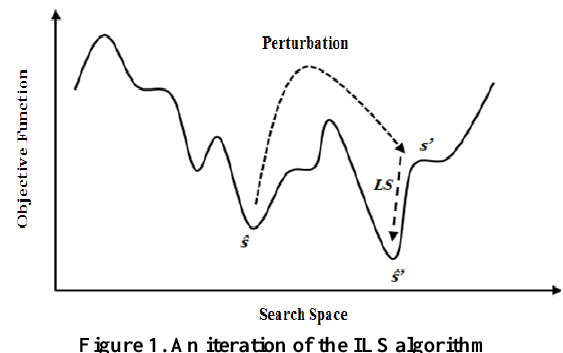
Figure 1. An iteration of the ILS algorithm The overall structure of the iterated local search algorithm is as